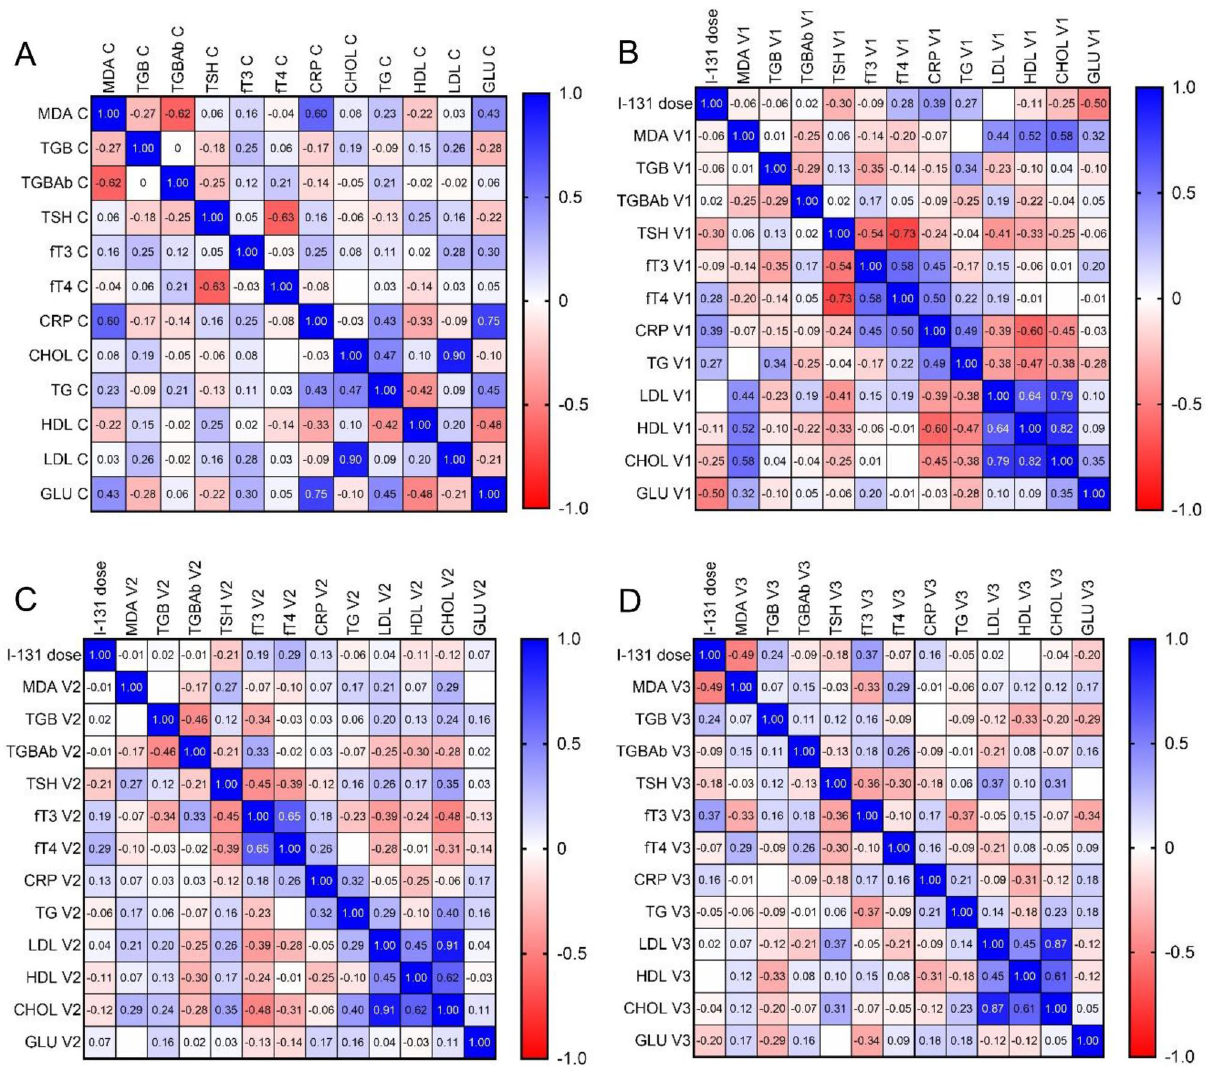
Additionally, the TSH concentration correlated with the 131 I dose in the DTC patients three days after ablation treatment. The fT4 concentration also correlated with fT3 and CRP ( r = 0.58 and r = 0.50, respectively; both p < 0.05). A correlation between LDL and CHOL ( r = 0.79) and HDL ( r = 0.64) was also observed (both p < 0.05) (Fig. 3B). Among the biochemical parameters measured three days after ablation, TGBAb was in correlation with fT3 ( r = 0.33), HDL ( r = –0.30) and TGB ( r = –0.46) (both p < 0.50). Moreover, the TSH concentration correlated with fT3 ( r = –0.45), fT4 ( r = –0.39), and CHOL ( r = 0.35) (all p < 0.05). Furthermore, medium negative correlation was observed between TGB and fT3 concentration ( r = −0.34; p < 0.05). Correlations between TG and LDL, CRP, and CHOL were likewise demonstrated ( r = 0.29, r = 0.32, and r = 0.40, respectively; all p < 0.05). No association between biochemical measurements and the 131 I dose used in the ablation treatment was observed (Fig. 3C). Considering the follow-up parameters one year after ablation treatment, fT3 correlated with TSH ( r = –0.36), TG ( r = –0.37), and the 131 I dose used ( r = 0.37) ( p < 0.05 for all). Furthermore, medium negative correlation was observed between TGB and HDL concentration ( r = –0.33; p < 0.05). A correlation was also found between TSH and LDL ( r = 0.37; p < 0.05), as well as between HDL and CRP ( r = –0.31; p < 0.05) (Fig. 3D).